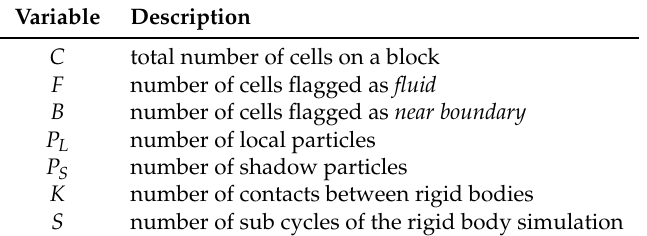
Table 1. Quantities that describe the state of a